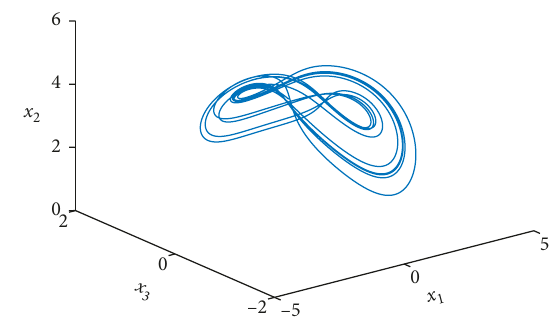
Figure 1: Chaotic attractor of financial system: α � 0 . 92 , τ � 0 . 01.